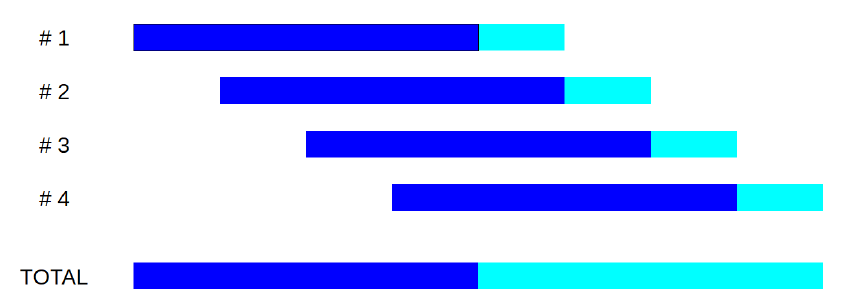
Figure 7. The final out-of-sample period is comprised of all smaller out-of-sample periods coming from different